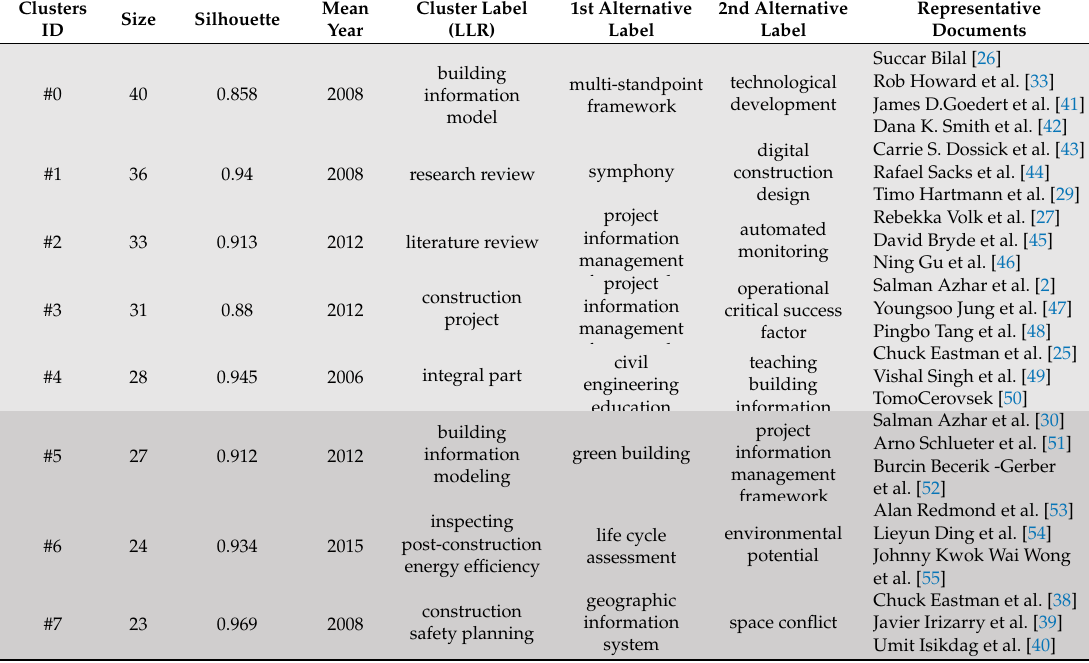
Figure 13. Document co-citation network—clusters analysis. Table 8. Co-citation clusters of BIM research in